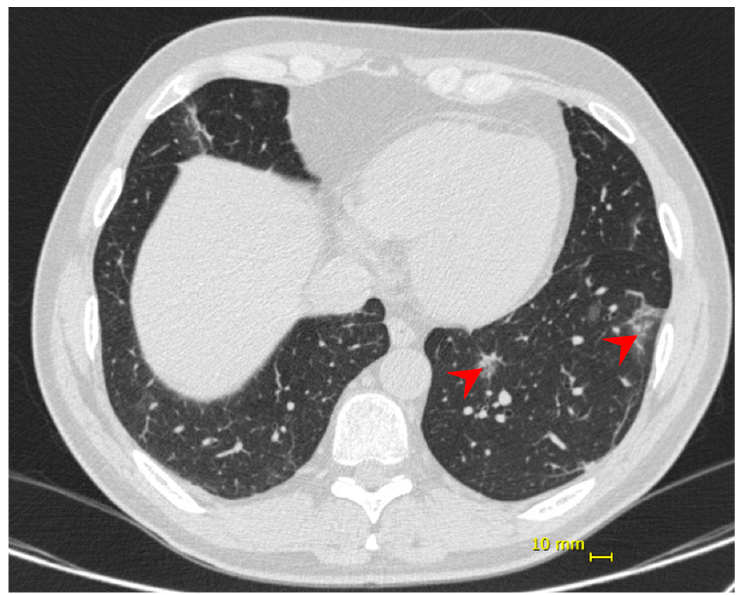
Figure 2. Patient 2—chest computed tomography showing bilateral multifocal ground-glass opacities (<25%) predominantly peripheral (red arrow).